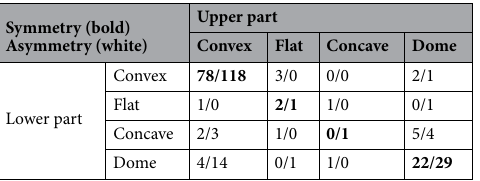
Table 1. Macular morphology in elementary/junior high school